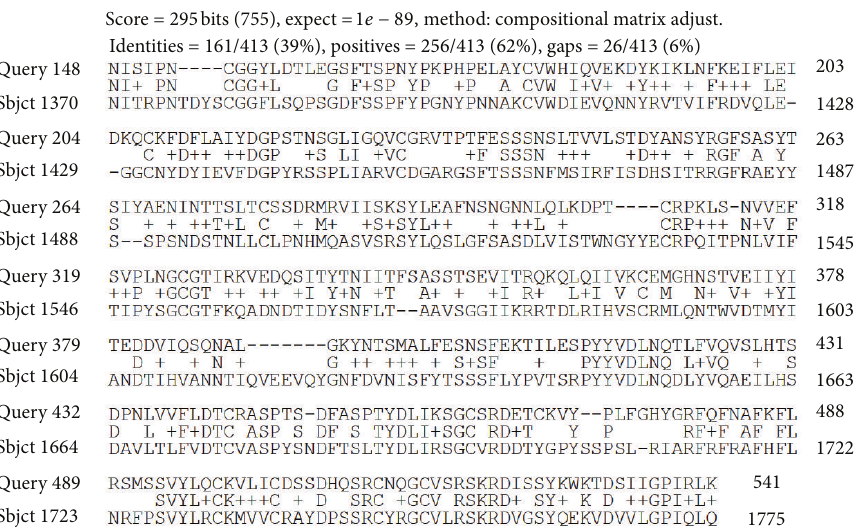
Figure1:AminoacidcomparisonbetweenhumanCUZD1andDMBT1.Thereisahighdegreeofhomologybetweenthetwoproteinspossibly reflecting the similarity between the CUB and ZP domains contained in both. The comparison has been performed using the BLASTp2 protein-protein programme. Top row: CUZD1; bottom row: DMTB1.